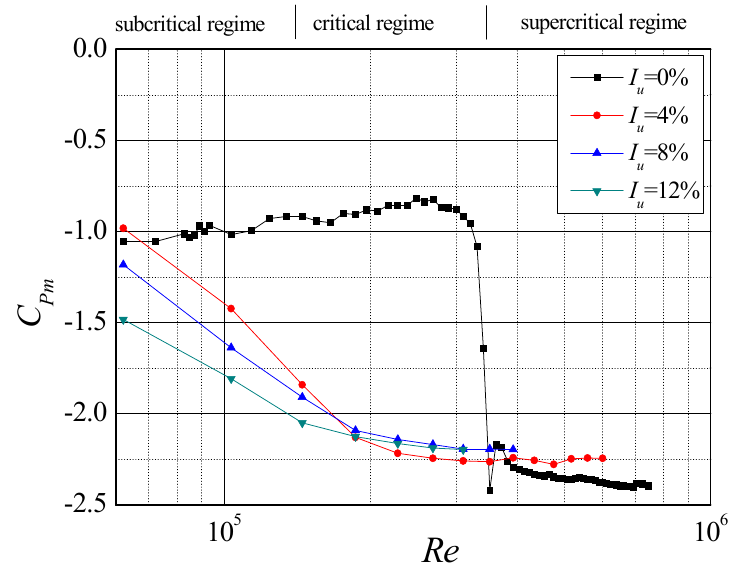
Figure 11. Minimum wind pressure coe ffi cient C pm in turbulent Figure 11 . Minimum wind pressure coefficient C pm in turbulent flow.